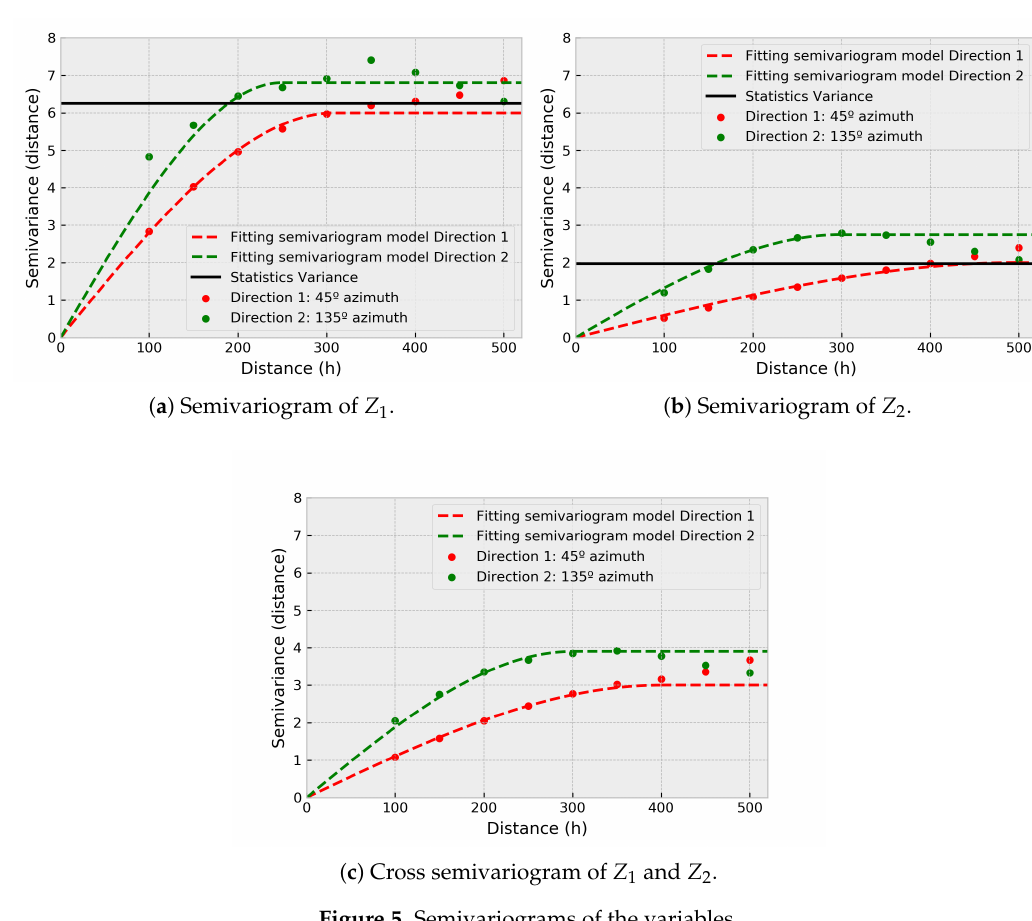
Figure 5. Semivariograms of the variables. . Table 4. Different scenarios depending on sampling